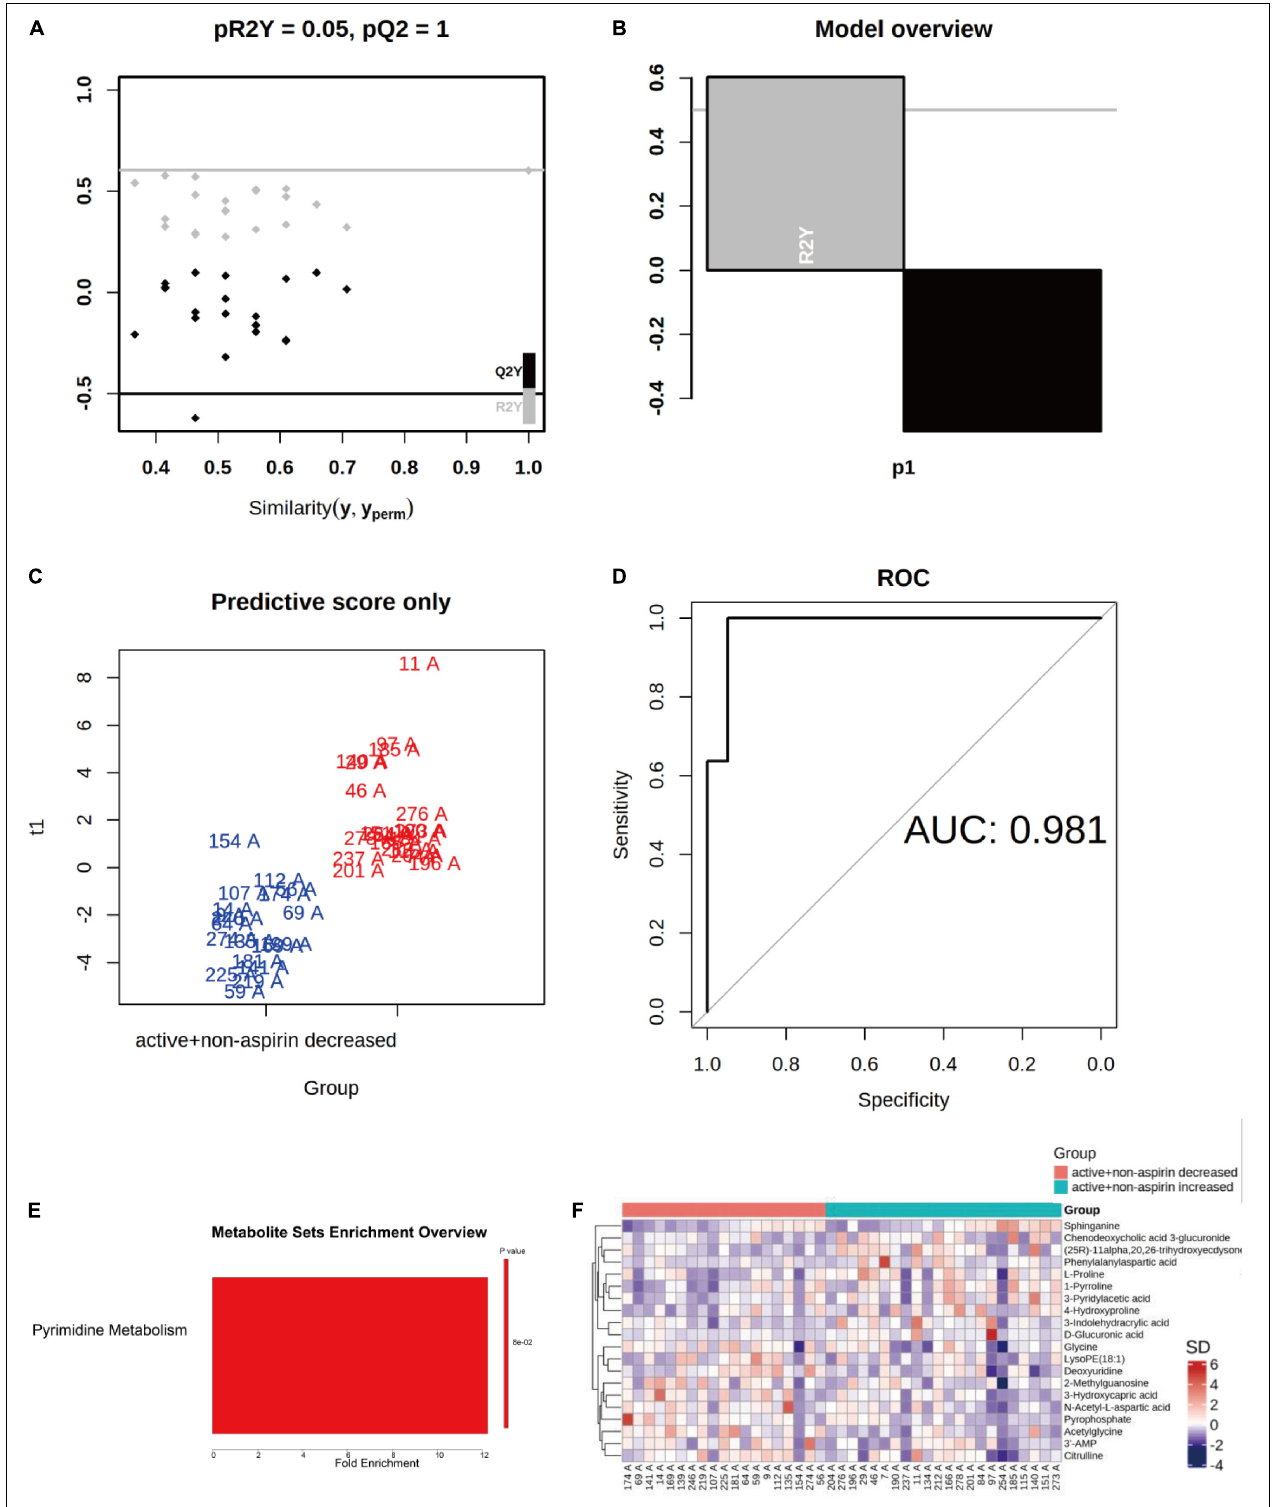
FIGURE 4 | Differences in baseline metabolome profiles between non-aspirin users on active B vitamin supplementation who responded positively (i.e., reduction in CDR-SOB) and negatively (i.e., increase in CDR-SOB) over the intervention period of 24 months. (A–D) OPLS-DA analysis of baseline serum metabolomes between the two groups; (E) Top altered metabolic pathway between the two groups; (F) Heatmap illustrates top altered metabolites based on VIP scores from OPLS-DA analysis.